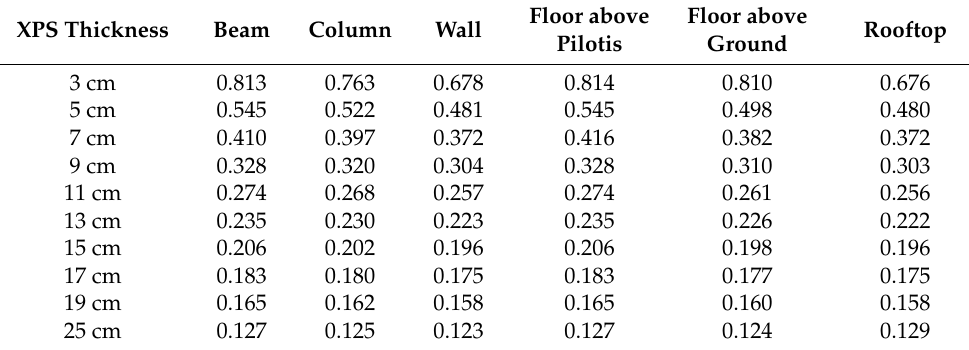
Table A1. U values of the reference building’s elements for each insulation scenario (W/m 2 K).